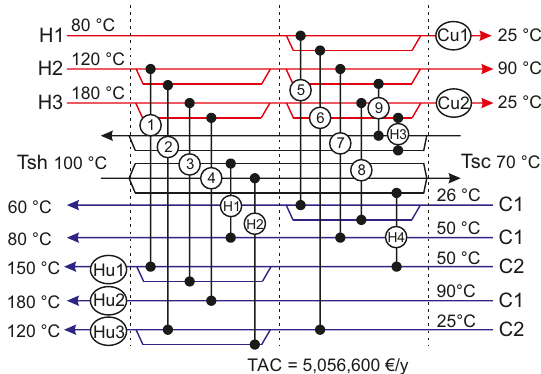
Figure 9. HEN obtained with HP and ST options case 4.